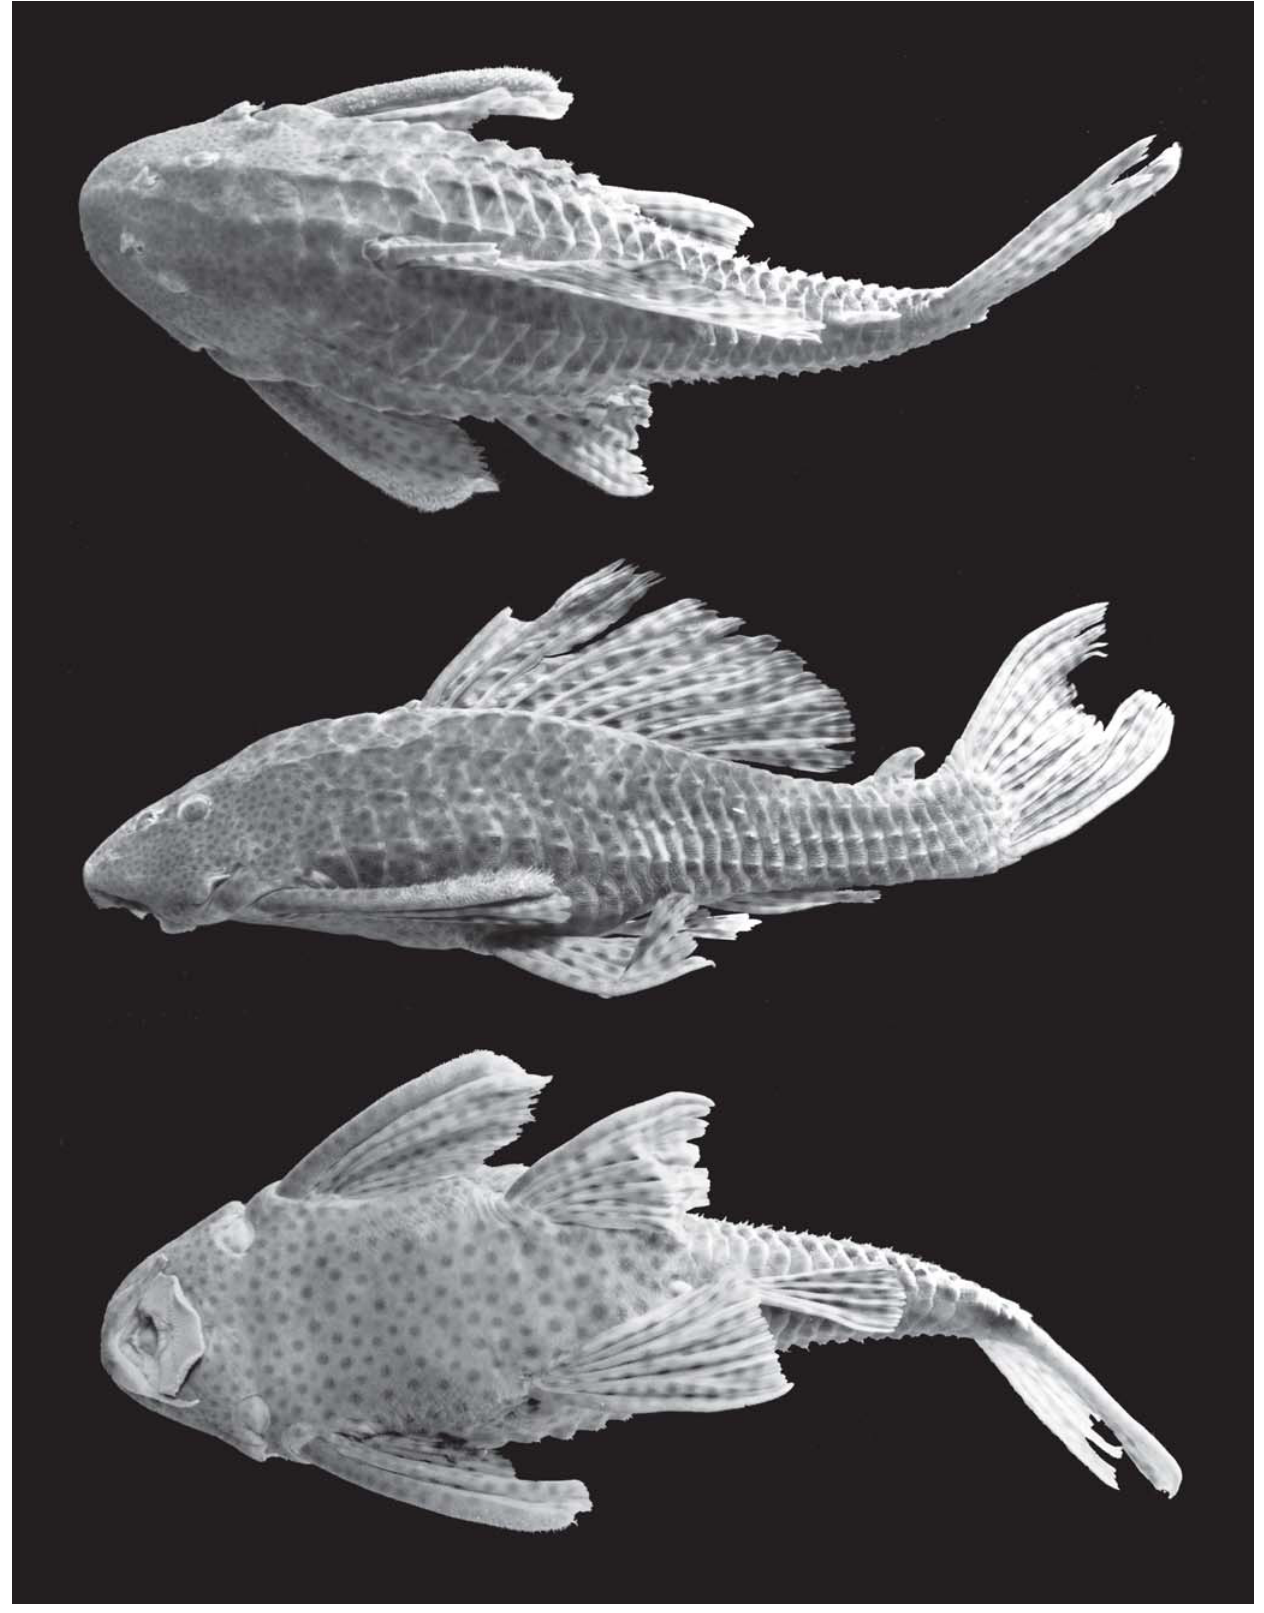
Fig. 5. Dorsal, lateral, and ventral views of Pterygoplichthys weberi , ICNMHN 13455, holotype, 191.4 mm SL. Photos by J.W. Armbruster and M.